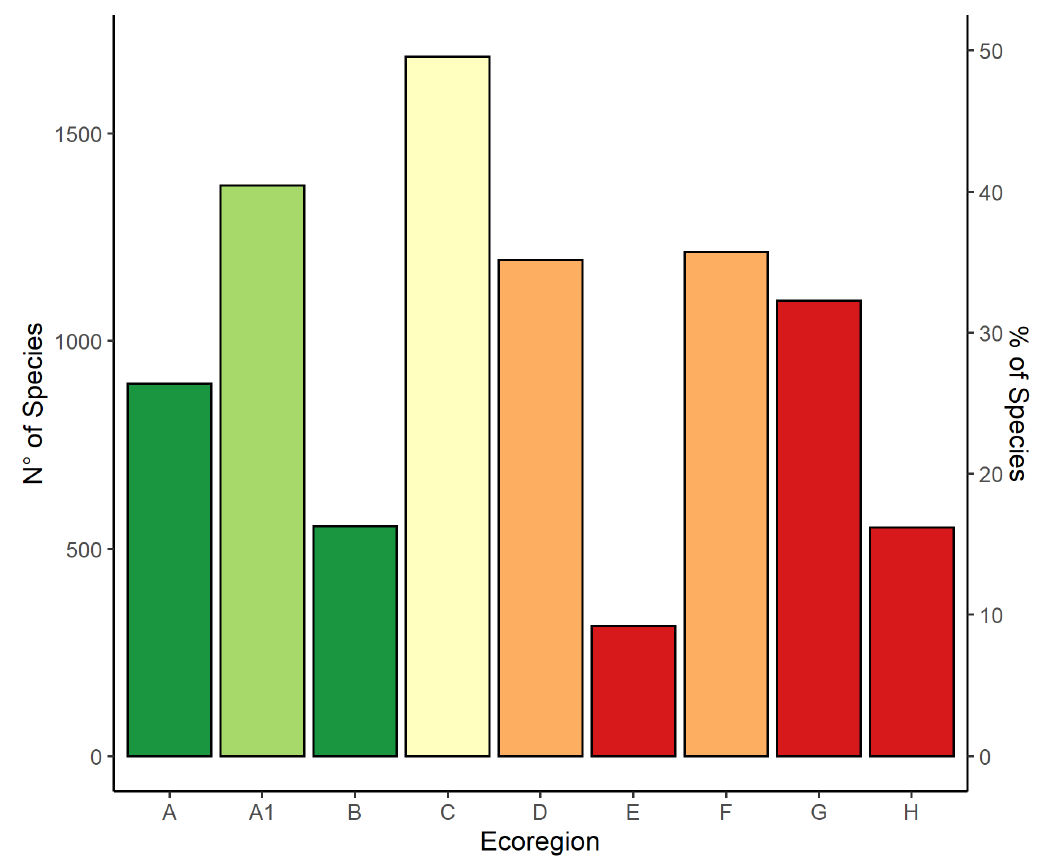
Figure 7. Bar-plot graph depicting the abundance of taxa occurring in each of the 9 ecoregions: Alpine (A), Subalpine (A1), Oromediterranean (B), Montane (C), Dry Submediterranean (D), Padanian (E), Humid Submediterranean (F), Humid Mediterranean (G), Dry Mediterranean (H). Similar colors of the bars depict ecoregions occupying the same altitudinal range. Color codes are green (high-altitude ecoregions), yellow (Montane ecoregion), orange (Submediterranean ecoregions), and red (Mediterranean ecoregions).